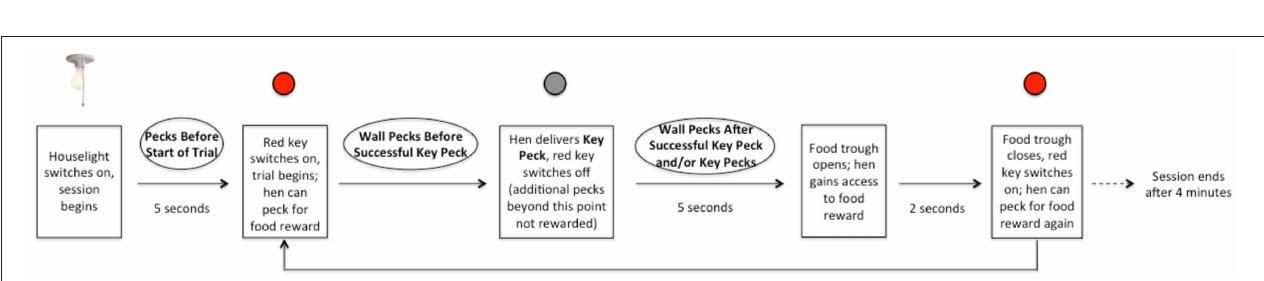
FIGURE 2 | Schematic of Operant Chamber set-up. (A) The red key is illuminated, and a key peck will result in food reward after a 5-s delay. The food trough is in a closed position. (B) The food trough is opened after a 5-s delay and the hen can access the food reward. The red key is not illuminated. Key pecks at the un-illuminated key do not result in food reward.